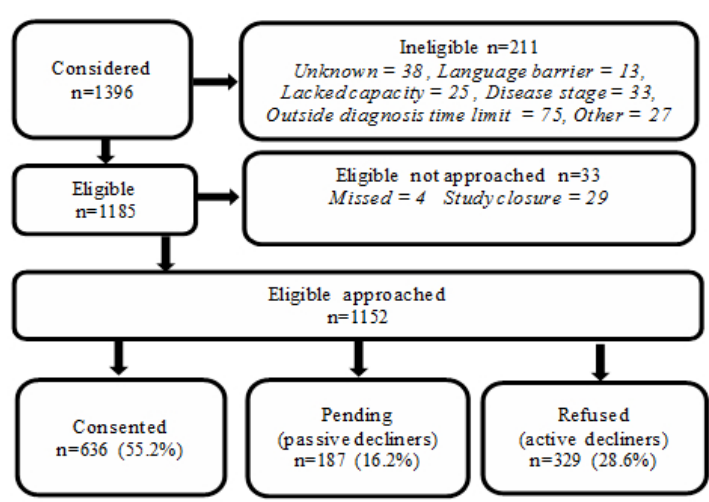
Figure 6. Flow chart of study